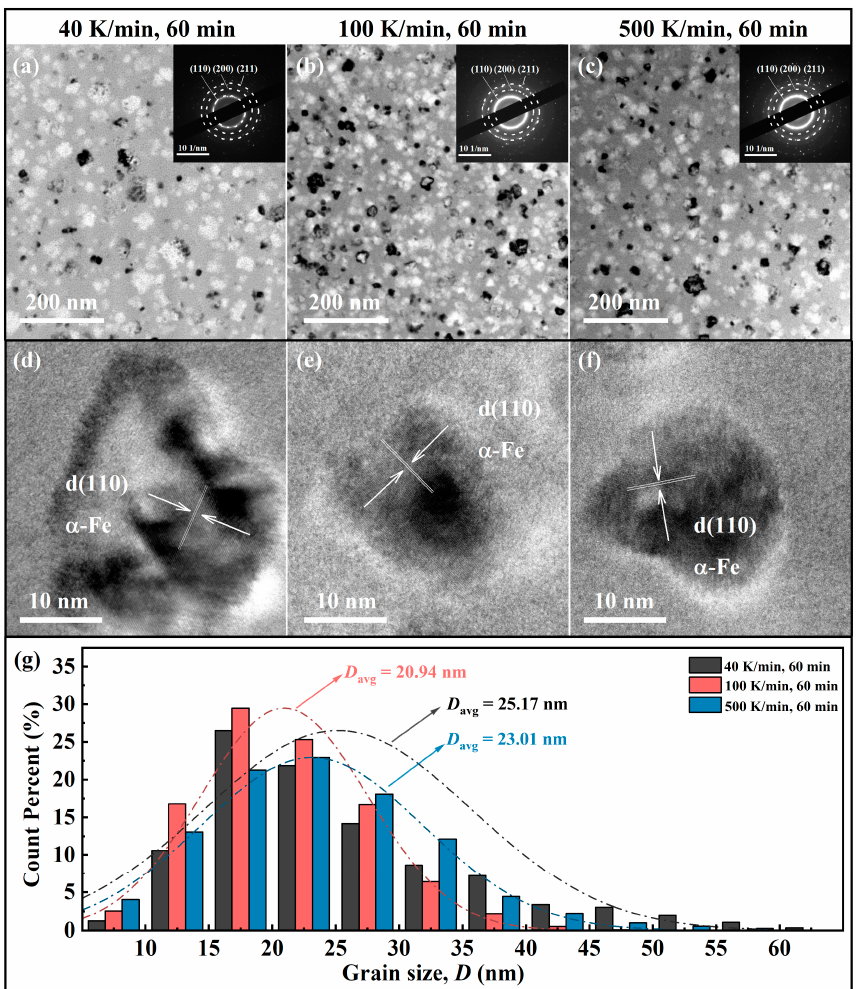
Figure 4. ( a – c ) TEM images and SAED patterns, ( d – f ) corresponding high-resolution TEM images, and ( g ) grain size distribution of Fe 74.75 Si 8 B 10 P 3 C 2 Nb 1.5 Cu 0.75 NPCs annealed at different HR .